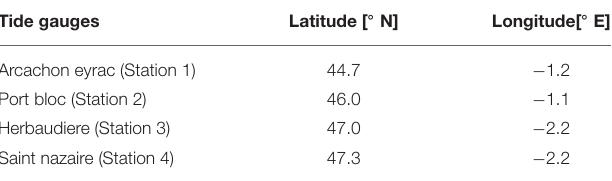
TABLE 1 | Geographic location of each tide gauge in the studied